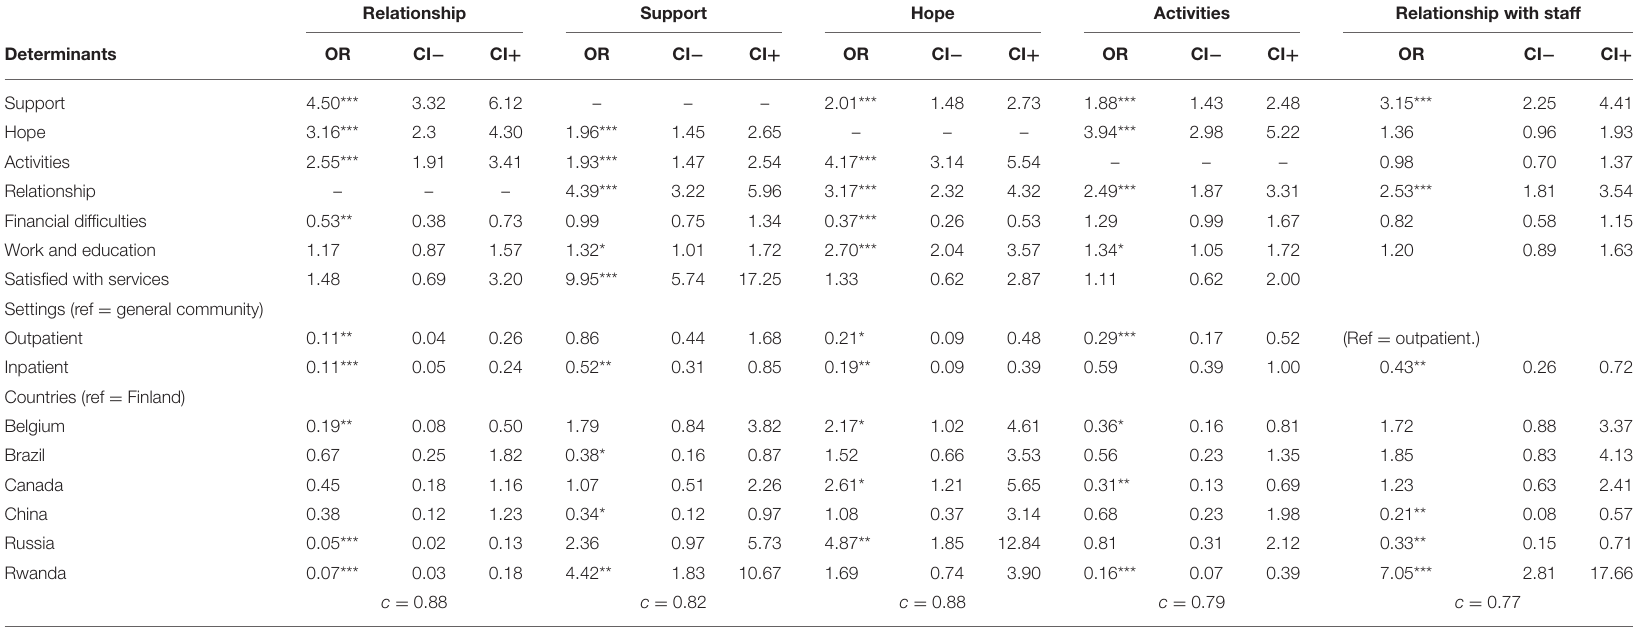
TABLE 2 | Adjusted logistic models for the interRAI SQoL-MHA domain